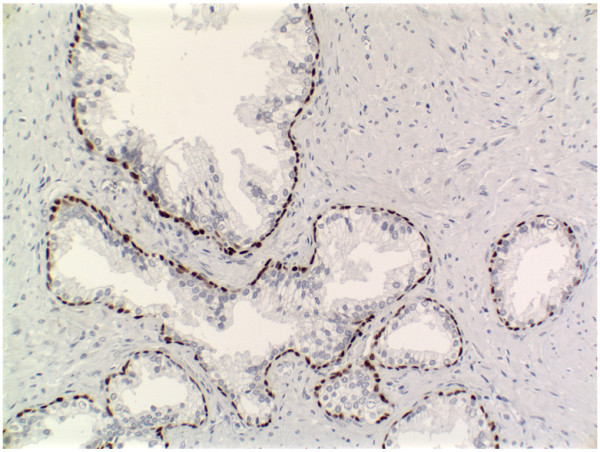
p63 Immunohistochemistry. Immunohistochemistry detecting p63 in the prostate. Brown color indicates positive staining. The expression of p63 protein in the prostate is confined to basal cells, which corresponds to the expression of its transcript in our data.